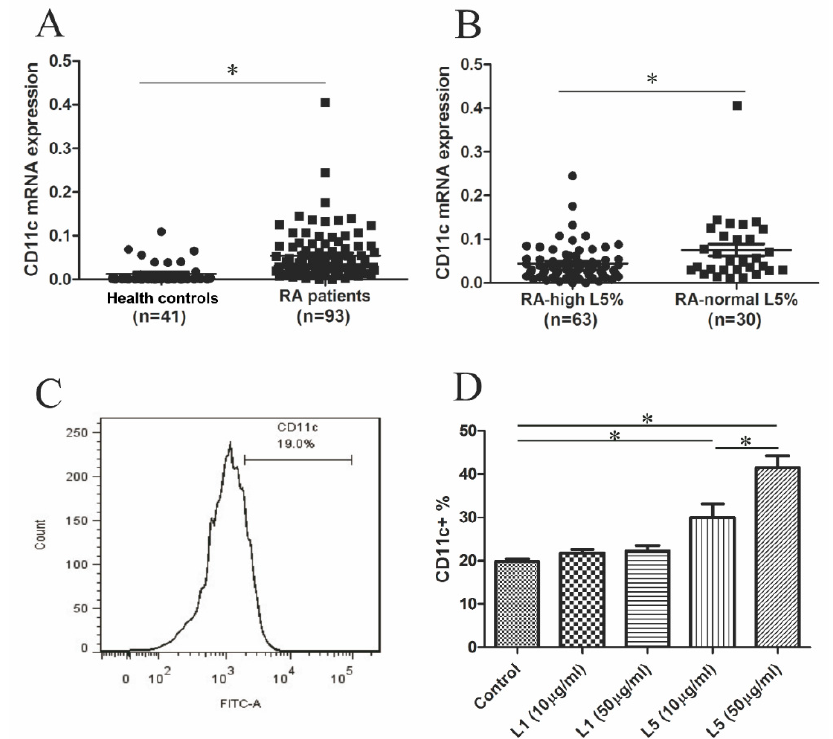
Figure 2. Comparison of CD11c ( ITGAX ) mRNA expression ( A ) between rheumatoid arthritis (RA) patients and healthy controls (HC), and ( B ) between RA patients with high L5% and normal L5%. ( C ) Representative histogram of the flow cytometric analysis of CD11c expression on THP-1 cells. ( D ) Bar graph showing the percent CD11c expression levels on THP-1 cells treated with different doses of L1 or L5 and fetal bovine serum (FBS)-treated control cells. Data are the mean ± SEM for three independent experiments. * p < 0.05.